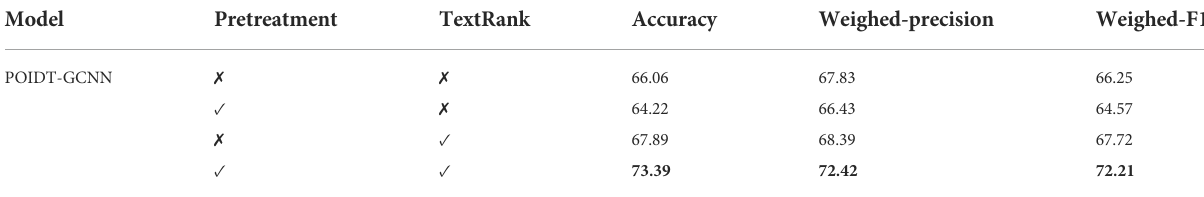
TABLE 3 Performance comparison of ablation experimental models.